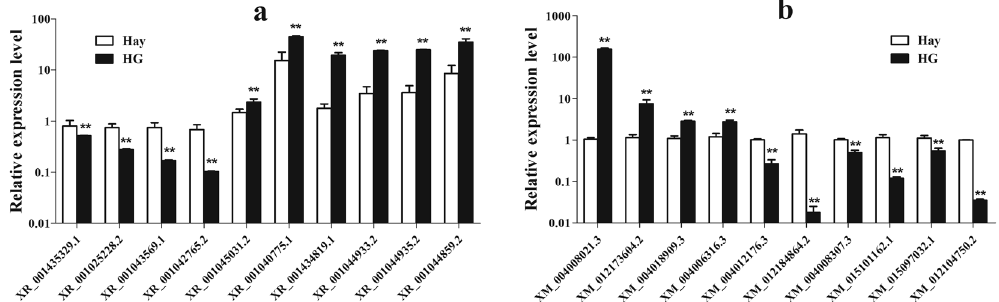
Figure 7. Verification of the expression level of ten DE transcripts in the hay and HG diet groups. The relative expression of DE lncRNAs and DE mRNAs in testis tissues was determined using qRT-PCR. ( a and b ) show the expression level of ten DE mRNAs and lncRNAs in the hay and HG diet groups, respectively. The experiment was biologically repeated 3 times and technically repeated 3 times for each group. The relative expression levels were normalized to the expression amount of GAPDH. The results are expressed relative to the hay group as the mean ± the SEM; * p < 0.05, and the Y-axis represents the values that were calculated by log10.